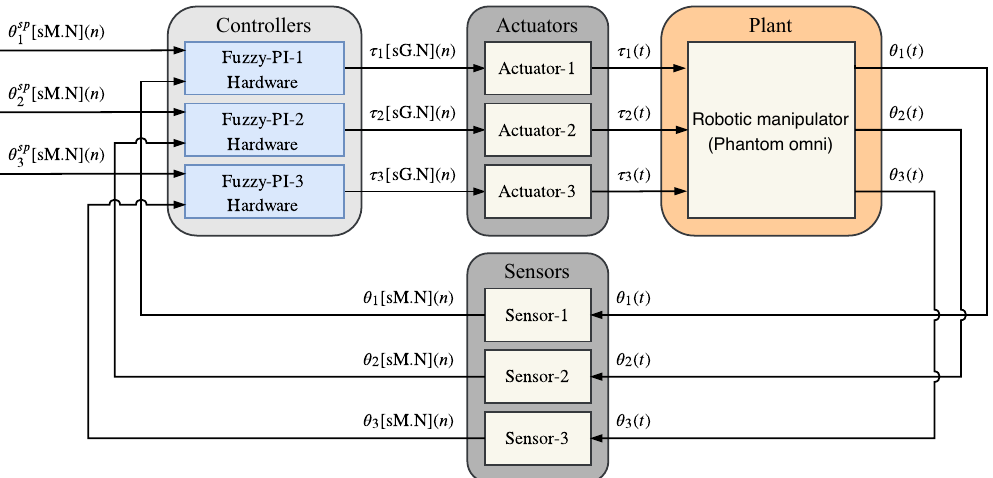
Figure 21. Simulated system used to validate the Fuzzy-PI hardware proposal. The plant is the 3DOF Phantom Omni robotic manipulator and there are three pieces of Fuzzy-PI hardware running in parallel.